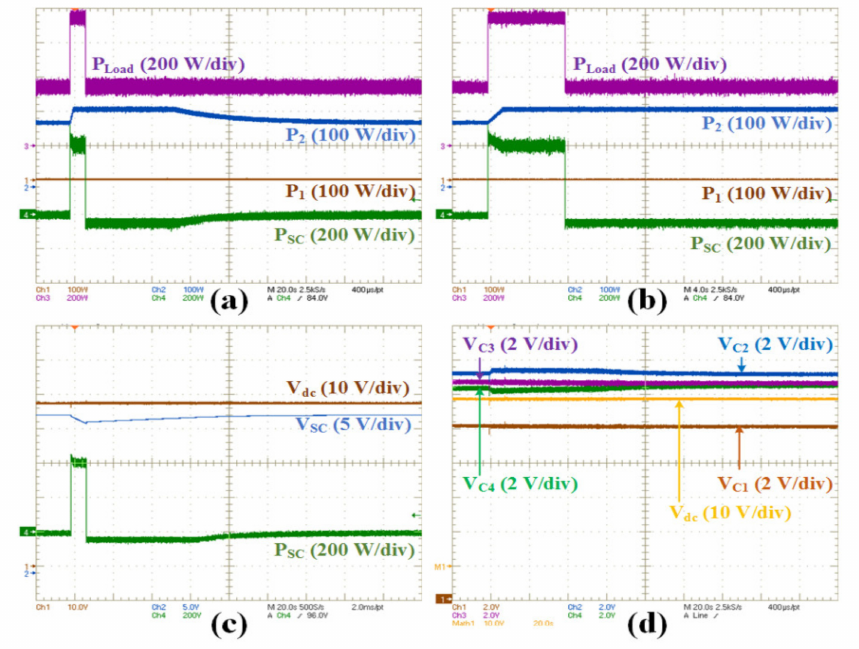
Figure 21. Experimental result of the energy management system when the stacks are in the normal condition except the first stack (flooding condition) and an overload occurs: ( a ) Injected power and load power variations; ( b ) Zoom on the powers; ( c ) DC link and SC voltage changes; ( d ) Output capacitor voltage